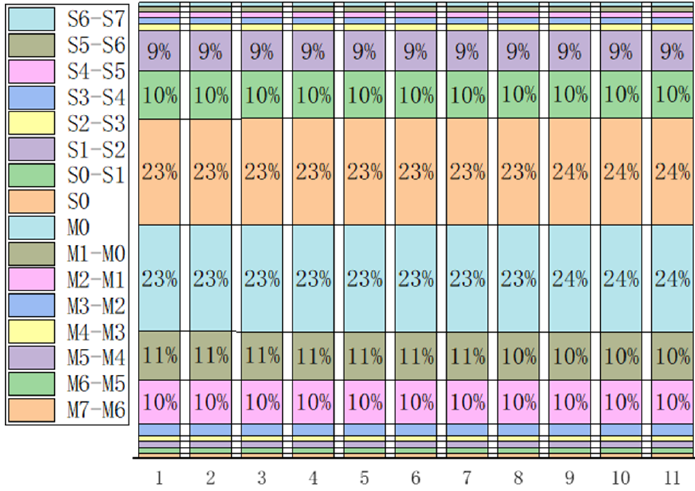
Figure 10. Influence of the initial peak force Fmax change on specific impact interfaces: ( a ) head car, ( b ) the first middle car interfaces: M1–M0 and S0–S1. Figure 11. Energy distribution at each interface with the change in the initial peak force.